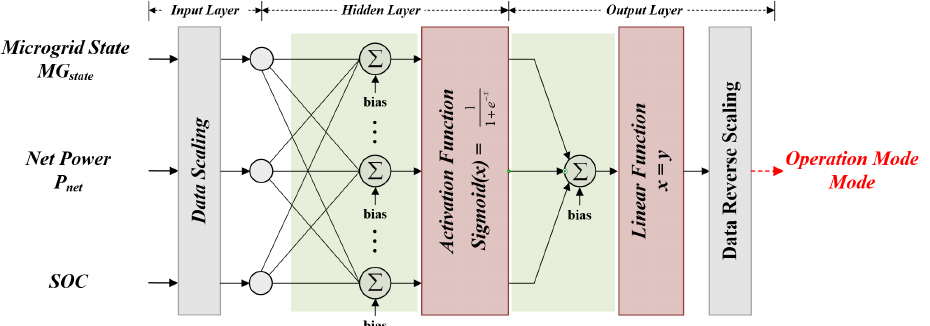
Figure 5. Configuration of first step of ANN structure.